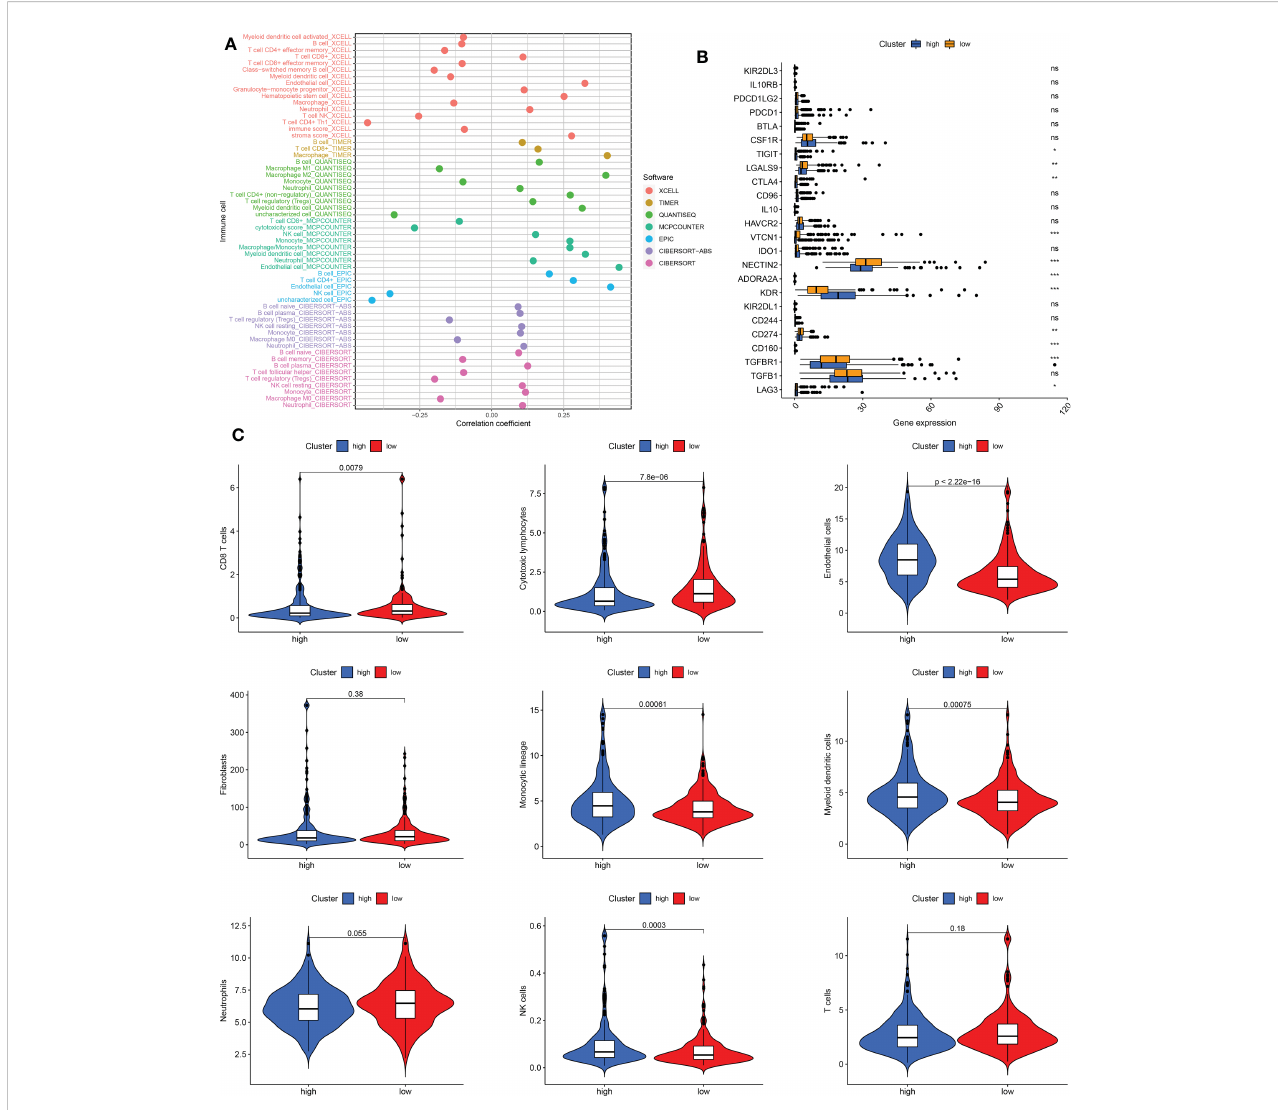
FIGURE 7 Immune cell in fi ltration pattern in low- and high-risk THCA. (A) Correlation analysis of risk score and diverse immune cells using the XCELL, TIMER, QUANTISEQ, MCPCOUNTER, EPIC, CIBERSORT-ABS, and CIBERSORT algorithms. (B) Boxplot showing the expression difference of immune checkpoints in low- and high-risk THCA. (C) Violin plot showing in fi ltration of CD8 T cells, cytotoxic lymphocytes, endothelial cells, fi broblasts, monocytic lineage, myeloid dendritic cells, neutrophils, NK cells, and T cells in low- and high-risk THCA. ns, no signi fi cance. * indicated P<0.05; ** indicated P<0.01; *** indicated